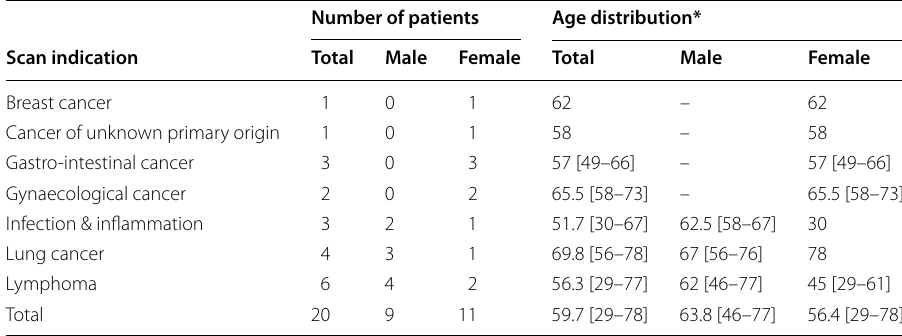
Table 1 AIF group: PET study indication and population